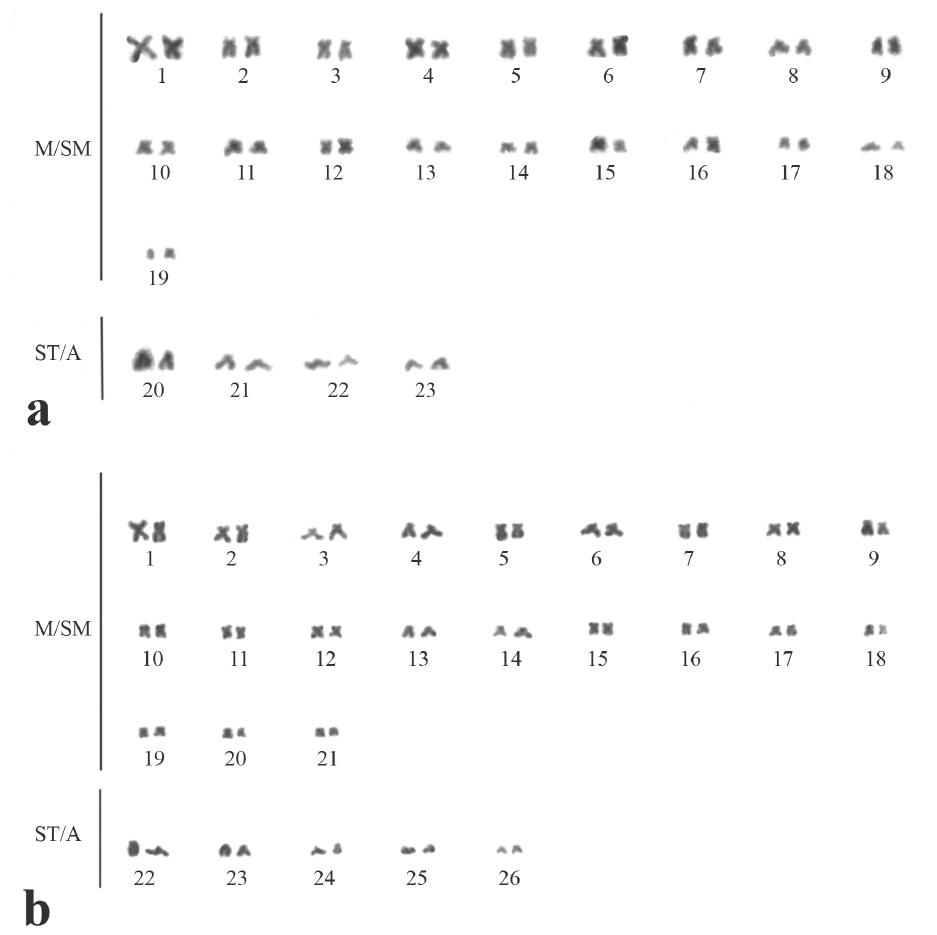
Fig. 2. Karyotypes of Pimelodella from the Miranda River, Passo do Lontra, Mato Grosso do Sul State. ( a ) 2n = 46, and ( b ) 2n =